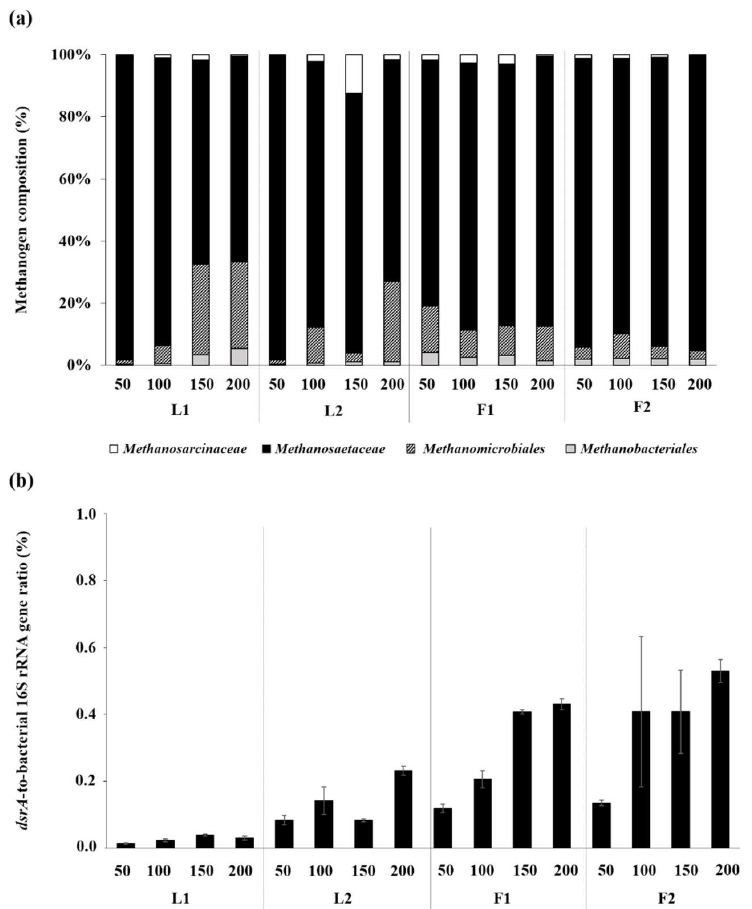
Figure 5. Methanogen community composition ( a ) and the dsrA -to-the-total bacterial 16S rRNA gene ratio ( b ) in the residual Ulva biomass in the LBR and the filter biomass in the AF. Samples are labeled with WRRs (mL/d) and the corresponding reactor names.